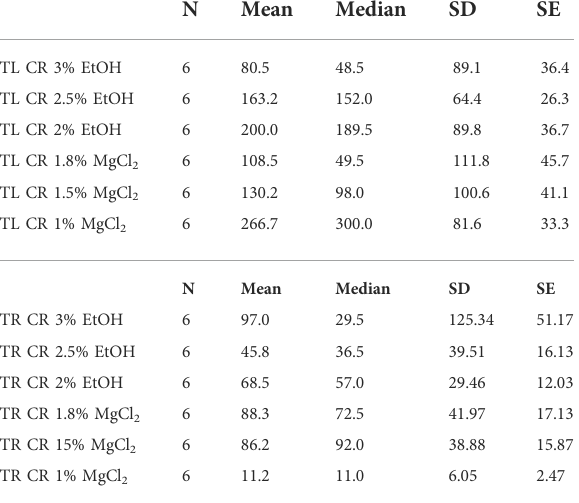
TABLE 4 Time until loss of chromatophore tone in seconds (TL CR) and time to recovery of chromatophore activity in seconds (TR CR) of L. vulgaris embryos exposed to different EtOH and MgCl 2 concentrations and the controls (no anesthetic solution). Measures are summarized (mean, median, SD, and